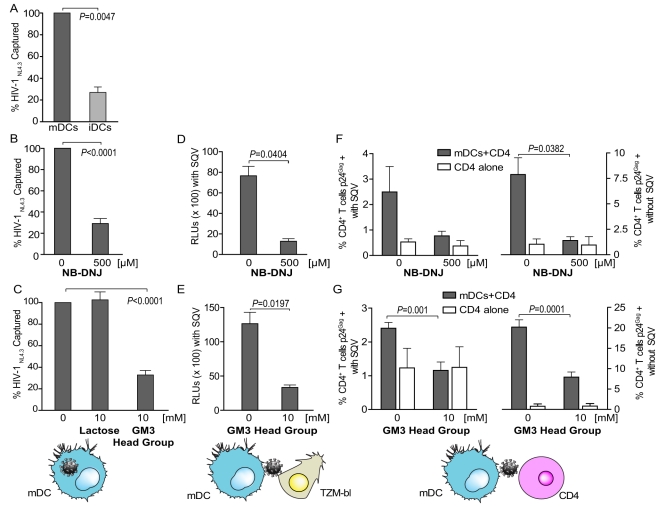
Sialyllactose in membrane gangliosides is required for mDC uptake and trans-infection of HIV-1.(A) Relative capture of HIVNL4-3 produced in primary cells by mDCs and iDCs. DCs were pulsed for 4 h at 37°C with equal amounts of a HIVNL4-3 produced in stimulated PBMCs, extensively washed, and then assayed for cell-associated p24Gag content by ELISA. Results are expressed as the percentage of HIVNL4-3 captured by iDCs relative to mDCs, normalized to 100% of viral capture. Viral uptake was increased in mDCs compared to iDCs (p = 0.0047, one sample t test). Data show mean values and SEM from two independent experiments including cells from three donors. (B) Relative capture of HIVNL4-3 produced in CD4+ T cells that had been treated or not with the glycosphingolipid inhibitor NB-DNJ. mDCs were pulsed for 4 h at 37°C with equal amounts of HIVNL4-3 generated in NB-DNJ-treated or mock-treated CD4+ T cells and then assayed for p24Gag content. mDCs captured less HIVNL4-3 generated in NB-DNJ-treated CD4+ T cells (p<0.0001, one sample t test). Data show mean values and SEM from two independent experiments including cells from six donors. (C) Competition of HIVNL4-3 capture by mDCs in the presence of the GM3 head group. mDCs were either pre-incubated with 10 mM lactose, 10 mM GM3 head group, or mock treated, and were then pulsed for 4 h at 37°C with equal amounts of HIVNL4-3 generated in CD4+ T cells. Virus uptake was assayed by ELISA for p24Gag. HIVNL4-3 capture was strongly reduced upon pre-treatment with the GM3 head group, but not lactose (p<0.0001, one sample t test). Data show mean values and SEM from two independent experiments including cells from six donors. (D) Transmission of HIVNL4-3 produced in NB-DNJ or mock-treated CD4+ T cells to the TZM-bl target cell line, which expresses the luciferase gene under control of the HIV LTR. mDCs treated as described in (B) but pulsed with an equal MOI of 0.1 were extensively washed and co-cultured with TZM-bl cells in the presence of saquinavir (to prevent second round infection) for 48 h before measurement of luciferase activity. Trans-infection was less efficient for HIVNL4-3 generated in NB-DNJ-treated compared to untreated CD4+ T cells (p = 0.0404, paired t test). Data show mean values and SEM from one experiment including cells from three donors. (E) Competition of trans-infection of HIVNL4-3 in the presence of the GM3 head group. mDCs treated as described in (C) but pulsed with an MOI of 0.1 were extensively washed and co-cultured with TZM-bl in the presence of saquinavir for 48 h before measurement of luciferase activity. Trans-infection was significantly reduced by the GM3 head group (p = 0.0197, paired t test). Data show mean values and SEM from two independent experiments including cells from six donors. (F) Trans-infection of activated primary CD4+ T cells by co-culture with mDCs pulsed with HIVNL4-3 produced in NB-DNJ or mock- treated CD4+ T cells. mDCs were pulsed with HIVNL4-3 at an equivalent MOI of 0.1 as described in (B). Unwashed pulsed mDCs were subsequently co-cultured with primary CD4+ T cells for 48 h before measuring the intracellular p24Gag content in the lymphocyte gate (CD2+ and CD11c− cells) by FACS (filled bars). Equivalent amounts of cell-free HIVNL4-3 were used as a control (open bars). Experiments were done in the presence (left panel) or absence (right panel) of saquinavir to distinguish net trans-infection from re-infection events, respectively. mDCs transferred less HIVNL4-3 generated in NB-DNJ-treated CD4+ T cells (p = 0.0382, paired t test). Data show mean values and SEM from one representative experiment including cells from three donors. (G) Trans-infection of activated primary CD4+ T cells by co-culture with mDCs pulsed with HIVNL4-3 in the presence or absence of the GM3 head group. mDCs were pulsed with HIVNL4-3 at an equivalent MOI of 0.1 as described in (C). Unwashed pulsed mDCs were subsequently co-cultured with primary CD4+ T cells for 48 h before measuring the intracellular p24Gag content in the lymphocyte gate (CD2+ and CD11c− cells) by FACS, as detailed in (F). mDCs transferred less HIVNL4-3 upon treatment with the GM3 head group (p-values on the graph, paired t test). Data show mean values and SEM from two independent experiments including cells from six donors.